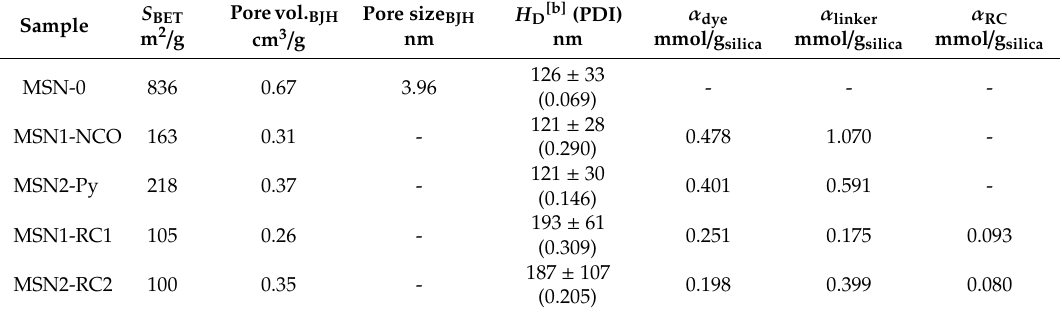
Table1. Characterizationparameters fromthe mesoporous silicananoparticlespreparedbeforeandafter each functionalization step determined by nitrogen-adsorption–desorption isotherms and by dynamic light scattering (DLS). Surface areas ( S BET ) were determined by applying the Brunauer–Emmett–Teller (BET) model. Content of safranin O, functional linker, and corresponding ruthenium complexes ( α dye , α α linker and RC ) were obtained by thermogravimetric analysis. Pore volumes (Pore vol.) and pore sizes were estimated by Barrett–Joyner–Halenda (BJH) model. Hydrodynamic diameters ( H D ) were obtained as average intensity values from at least three independent